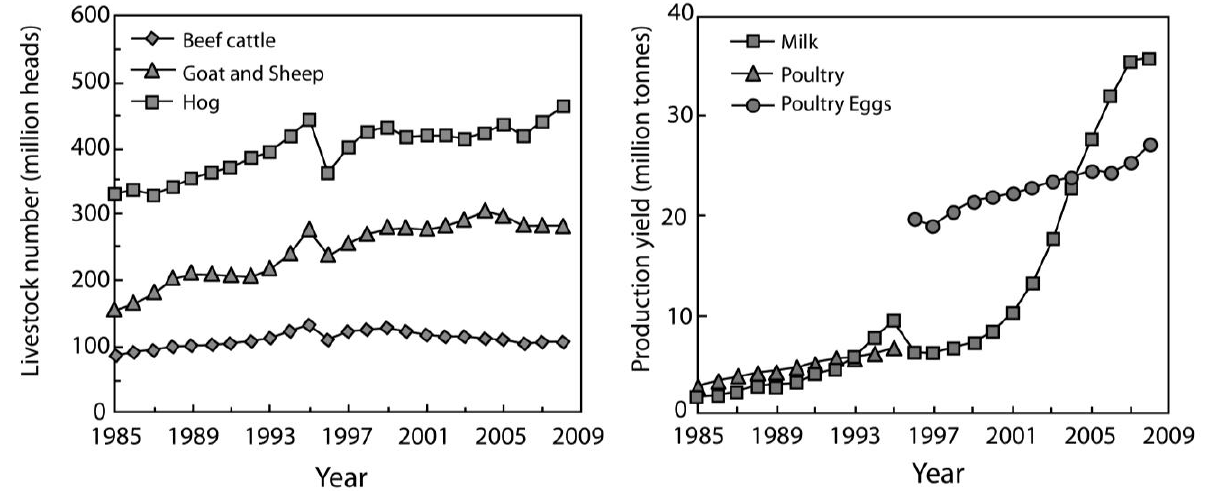
Fig. 8. Livestock numbers and milk and poultry production (1996-2008)(Source: Sun et al.,